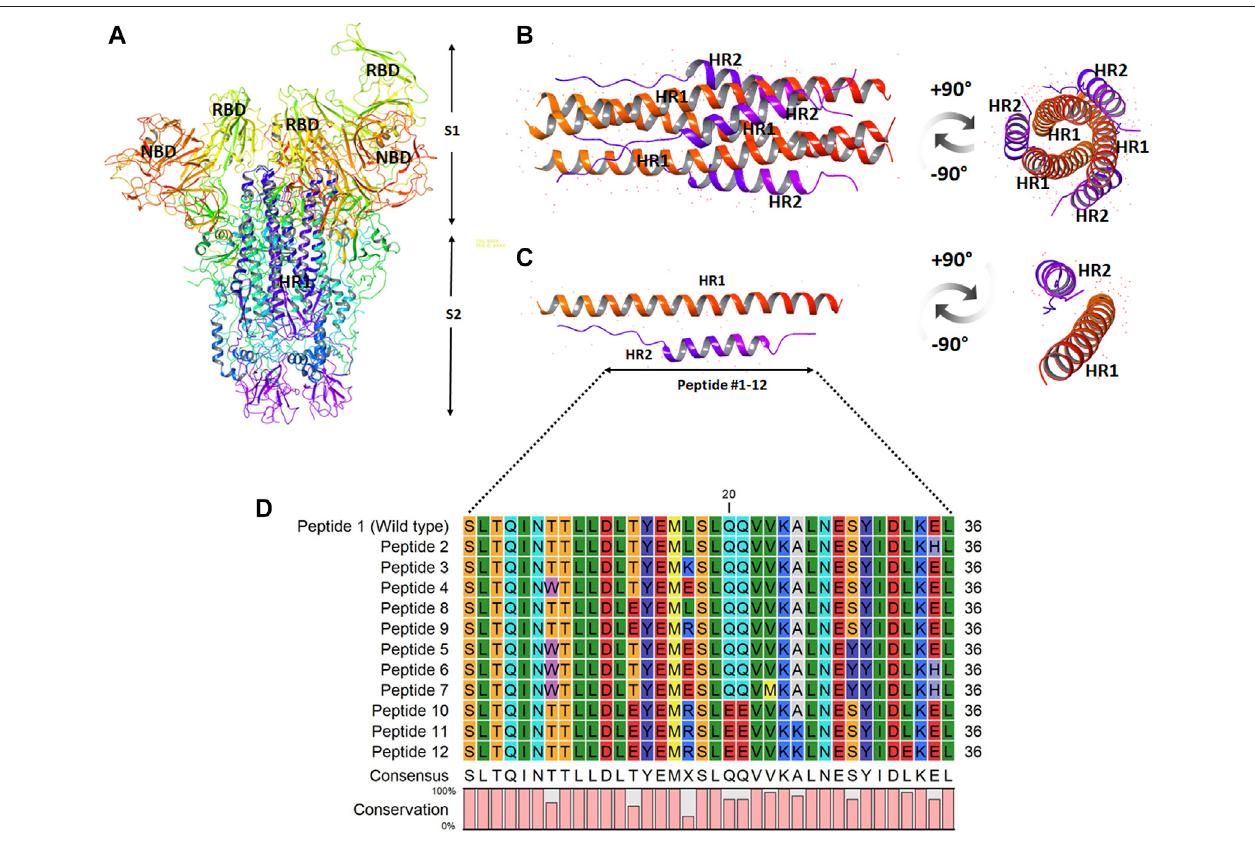
FIGURE 1 | The design and sequence of peptides 1 – 12. (A) The structure of MERS-CoV spike ectodomain showing the spike S1 and S2 subunits. (B) The fusion core showing trimers ofHR1 and HR2 in afull fusion state. (C) Monomers ofthe fusion core showing HR1-HR2 binding. The site of fusion peptide design isrepresented by the bidirectional arrow. (D) The sequence of the synthesized peptides 1 – 12. The color scale indicates the degree of residue